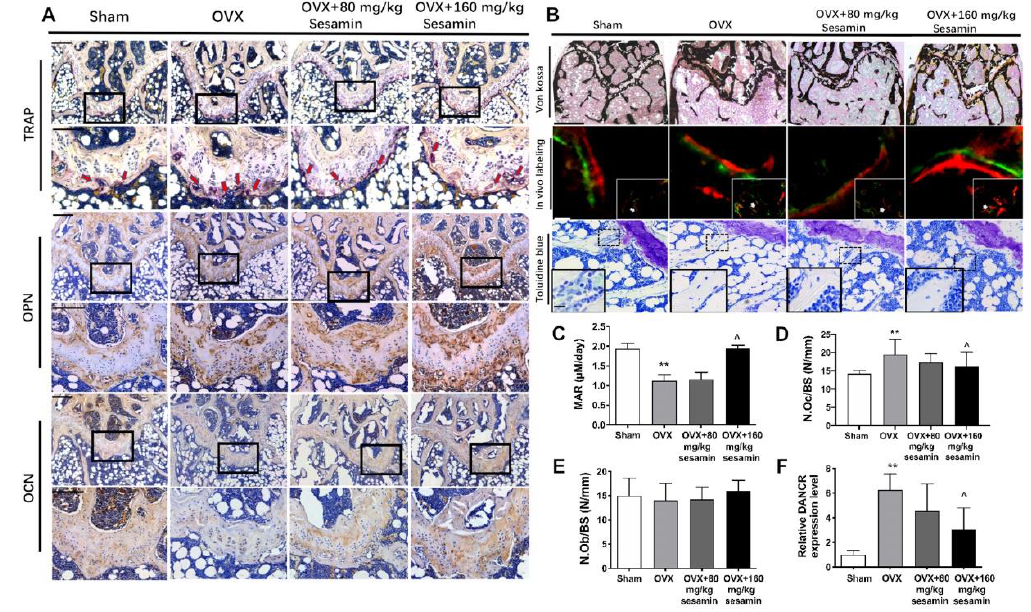
Figure 7. Histomorphometry of the distal femur from OVX mice upon sesamin treatment. ( A ) Representative images of femoral metaphysis with IHC staining using TRAP, OCN and OPN antibodies. Red arrow indicates the TRAP positive cells. Scale bar: 200 μM. ( B ) Von Kossa staining, in vivo double labels and Toluidine blue staining of the distal femur sections. Scale bar: 400 μM for Von Kossa, 100 μM for in vivo labeling and Toluidine blue staining. ( C – E ) Histomorphometric analysis of distal femur sections including MAR (mineral apposition rate) ( C ), N.Oc/BS (number of osteoclast per bone surface) ( D ) and N.Ob/BS (number of osteoblasts per bone surface) ( E ). ( F ) Serum level of DANCR was revealed in OVX mice upon sesamin treatment. Data were shown as mean ± SD ( n = 8; ** p < 0.01, versus sham group; ^ p < 0.05. versus OVX group).